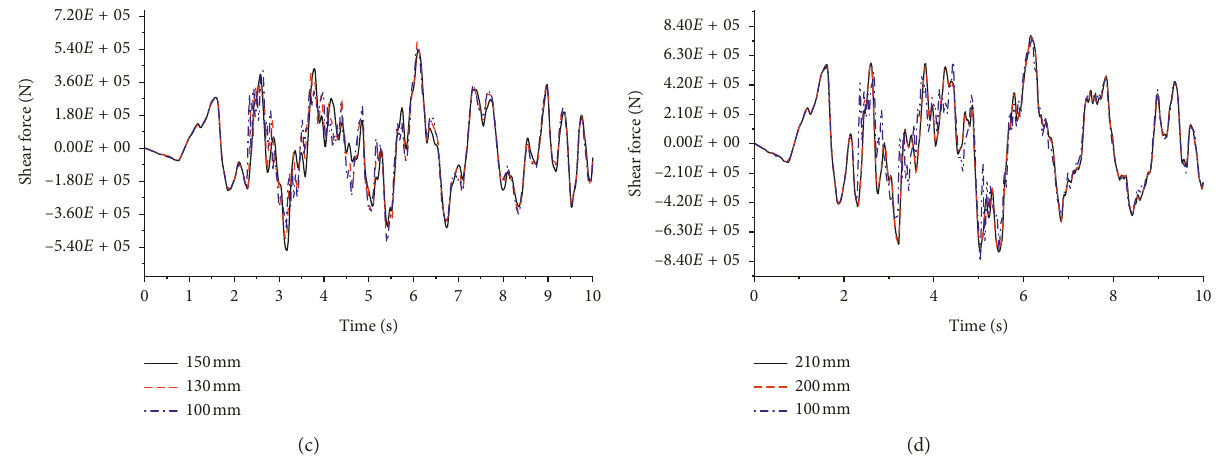
2 , (b) 70 cm/s 2 , (c) 220cm/s 2 , and (d) 400cm/s 2 . 2 -A 31 . (a) 35cm/s